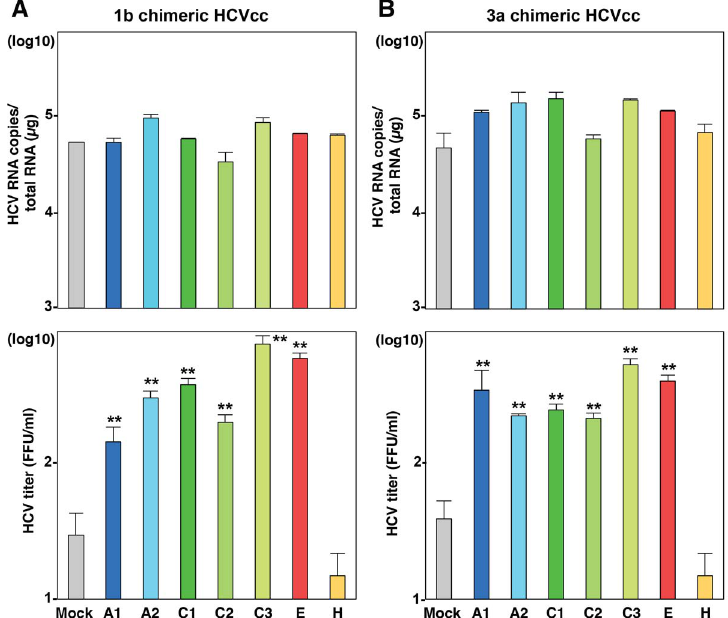
Figure 5. Exchangeable apolipoproteins participate in the formation of infectious HCV particles of genotype 1 and 3. ApoA1, ApoA2, ApoC1, ApoC2, ApoC3, ApoE and ApoH were exogenously expressed in BE-KO1 cells by infection with lentiviral vectors, and then infected with genotype 1b and 3a chimeric HCVcc, TH/JFH1 (A) and S310/JFH1 (B) at an MOI of 0.5. Intracellular HCV RNA and infectious titers in the culture supernatants were determined at 72 h post-infection by qRT-PCR (upper) and focus-forming assay (lower). Asterisks indicate significant differences (**, P , 0.01) versus the results for control cells.